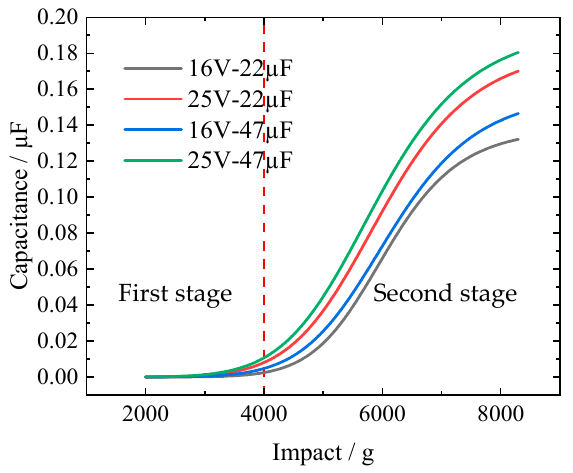
Figure 8. Relationship between capacity change and impact acceleration.